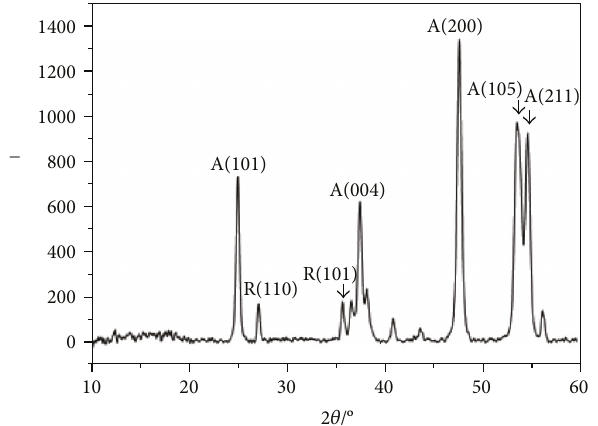
Figure 3: XRD pattern of the as-prepared TiO of anatase (A) and rutile (R) crystal